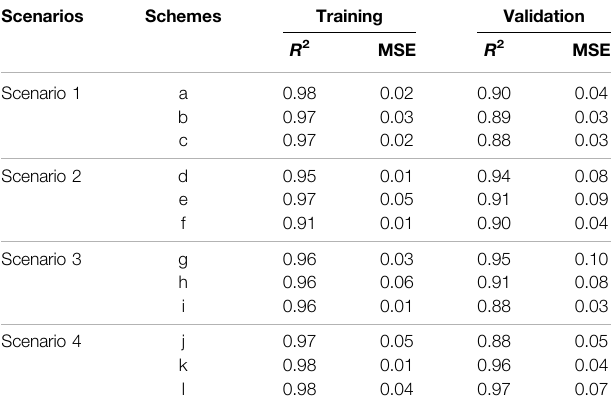
TABLE 3 | The performance evaluation of the RF